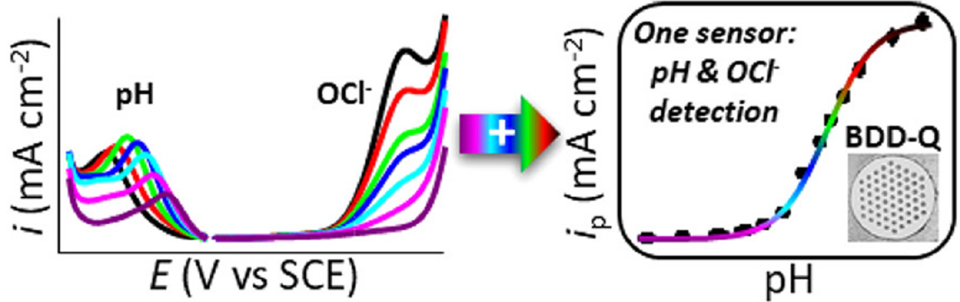
Figure 13. Schematic representation of sp 2 -BDD electrode-mediated detection of pH and OCl − (reproduced with the permission of [112]).